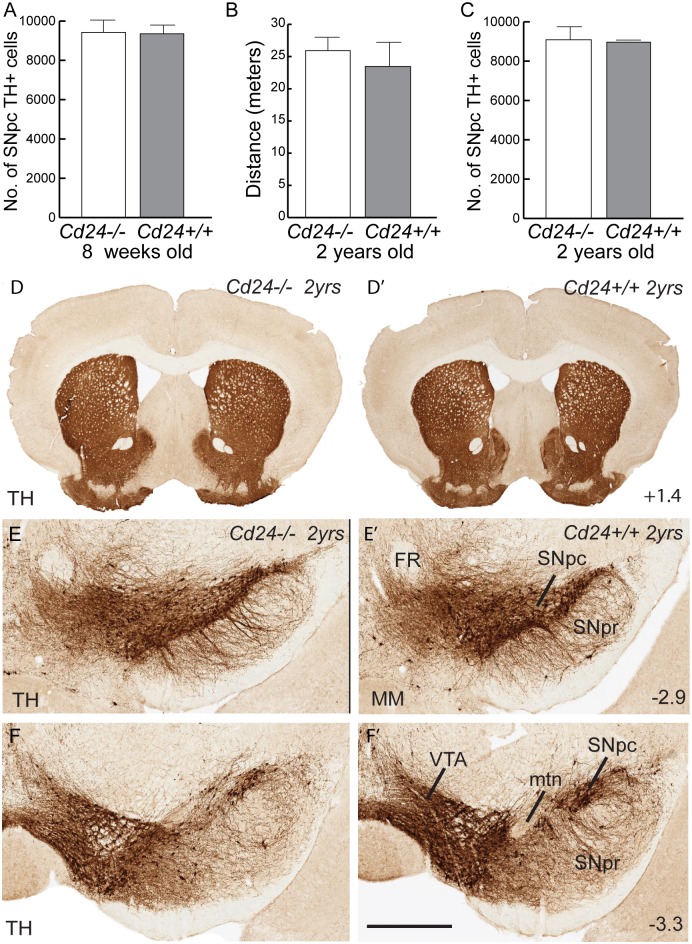
The midbrain dopamine system of the Cd24 mutant mouse is normal.(A) Stereological estimations of the number of SNpc TH+ cells at 8 weeks of age. (B) Distance travelled in the open field arena by 2-year-old Cd24-/- and Cd24+/+ mice. (C) Stereological estimations of the number of SNpc TH+ cells at 2 years of age. (D) Tyrosine hydroxylase (TH) immunohistochemistry on coronal sections of a brain of a 2-year-old Cd24-/- mouse (left column) and a Cd24+/+ littermate (right column), at the level of the striatum. (E) A coronal section of the SNpc at the level of the fasciculus retroflexus (FR) and the caudal end of the mammillary bodies (MM). (F) Images of the VTA and SNpc at the level of the medial terminal nucleus of the accessory optic tract (mtn). Co-ordinates in the right-hand corners of panels D, E and F indicate location of the coronal plane relative to bregma. The scale bar in panel F represents 1cm in panel D, 200μm in panel E, and 300μm in panel F.